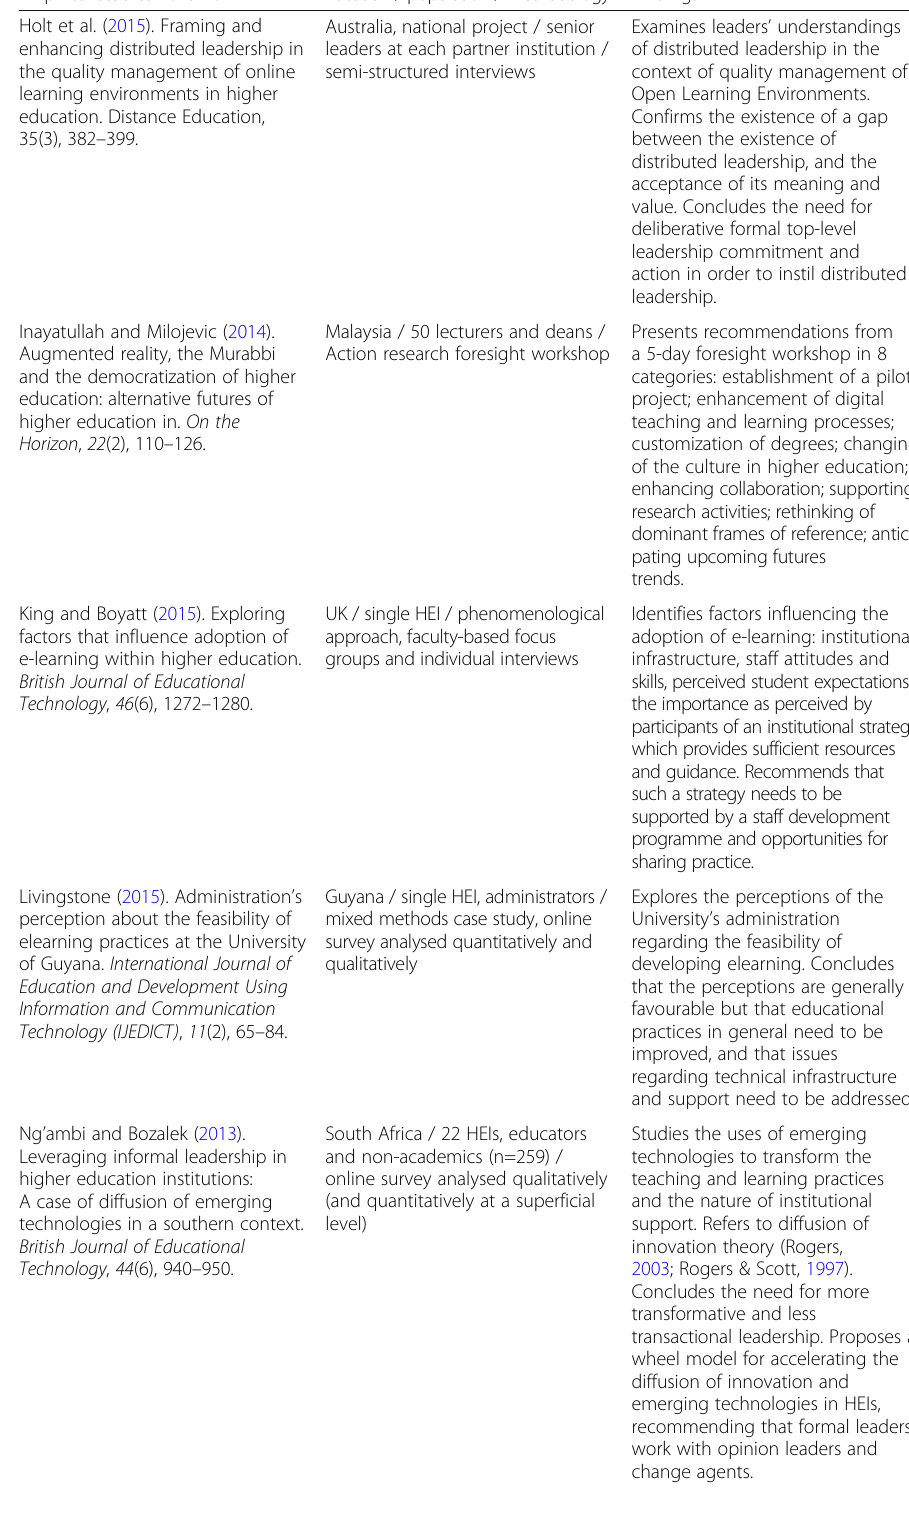
Table 2 Results: Empirical studies (Continued) Empirical studies 2013-2017 Location / population / methodology